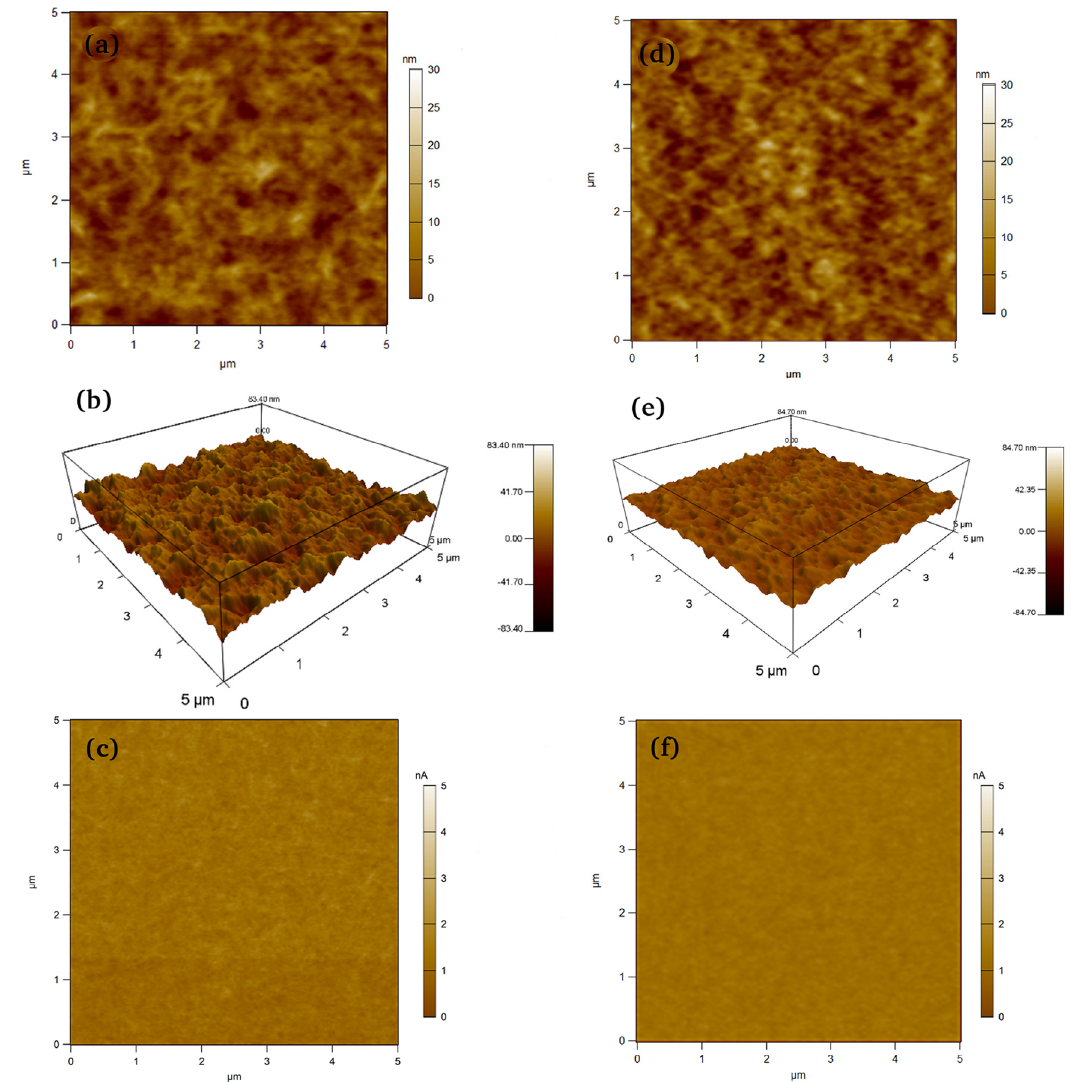
Figure 4. (a) AFM morphology image, (b) height images of the surface morphology and (c) C-AFM current images of a ref-OSC film; (d) AFM morphology image, (e) height images of the surface morphology and (f) C-AFM current images of a CFO-OSC film.